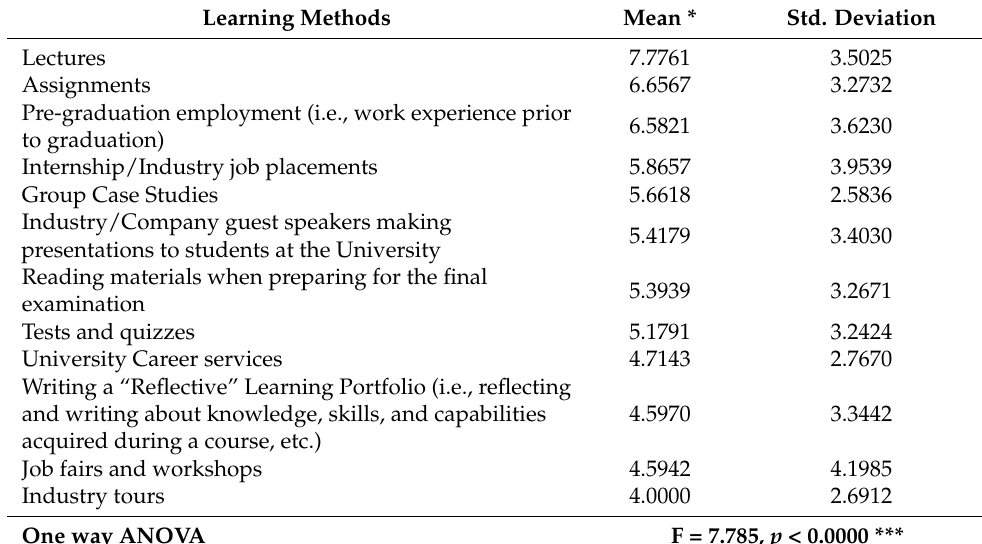
Table 7. Learning methods used to acquire employability skills (students’